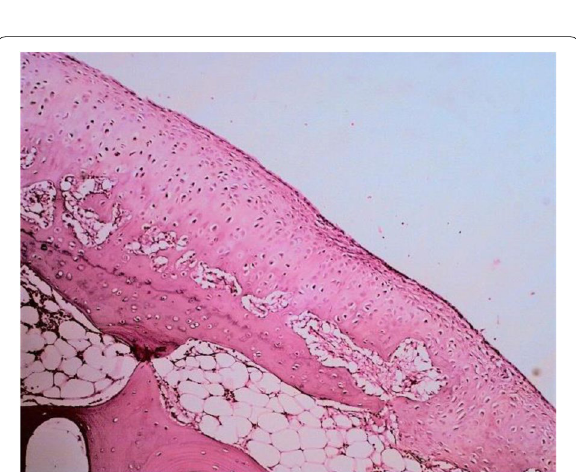
Fig. 4 Microscopic appearance in GH3 group showing hypercellular area of cartilage